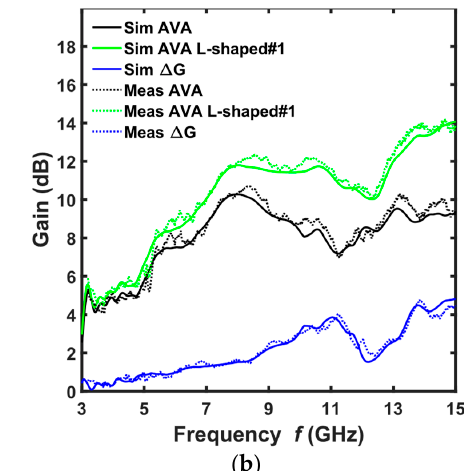
Figure 13. Prototypes of antipodal Vivaldi antenna without and with metalens: ( a ) AVA, and ( b ) AVA L-shaped#1.